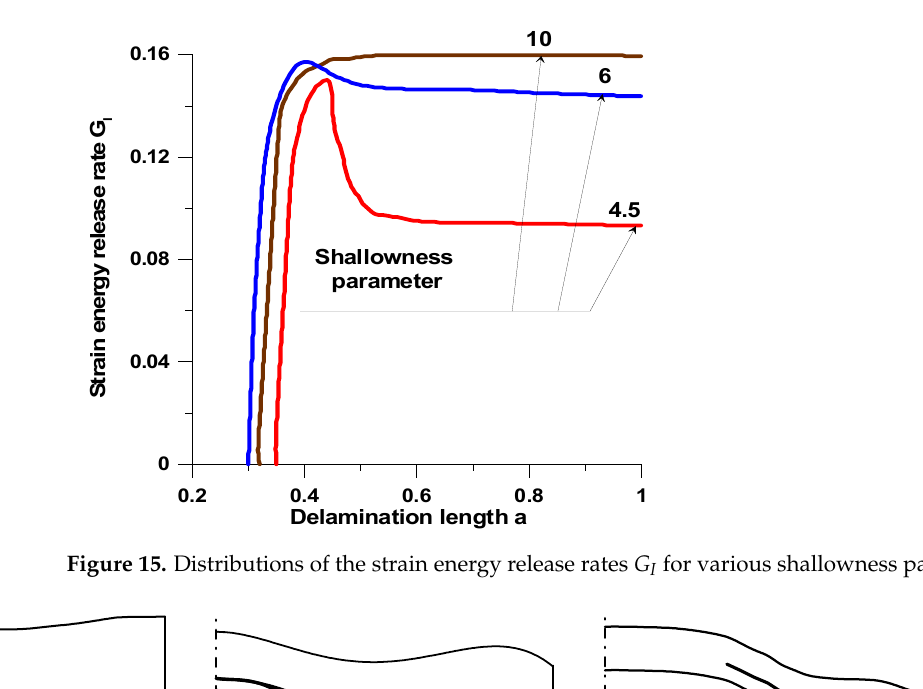
Figure 16. Buckling modes of axi-symmetric spherical shell with a single delamination being the function of the shallowness parameter ρ .